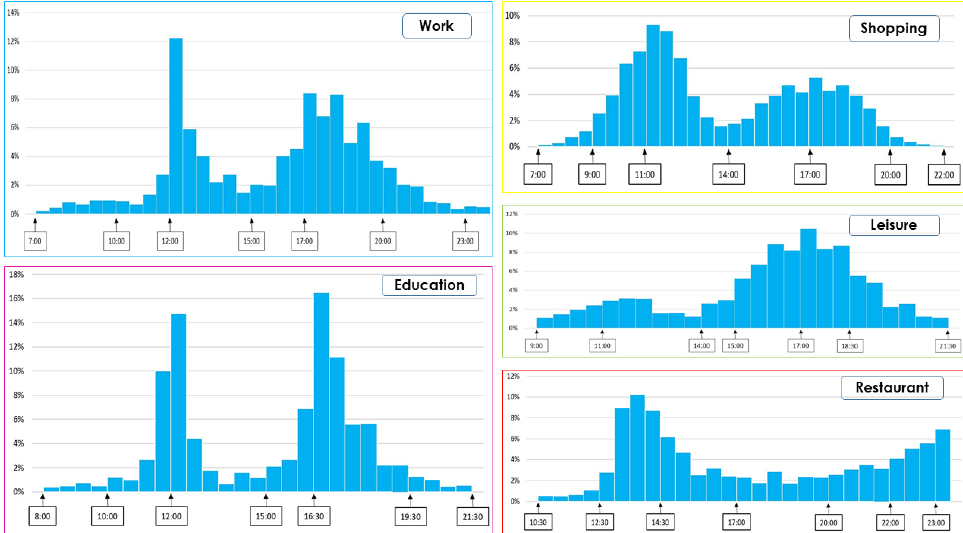
Figure 9. The duration distribution for the different